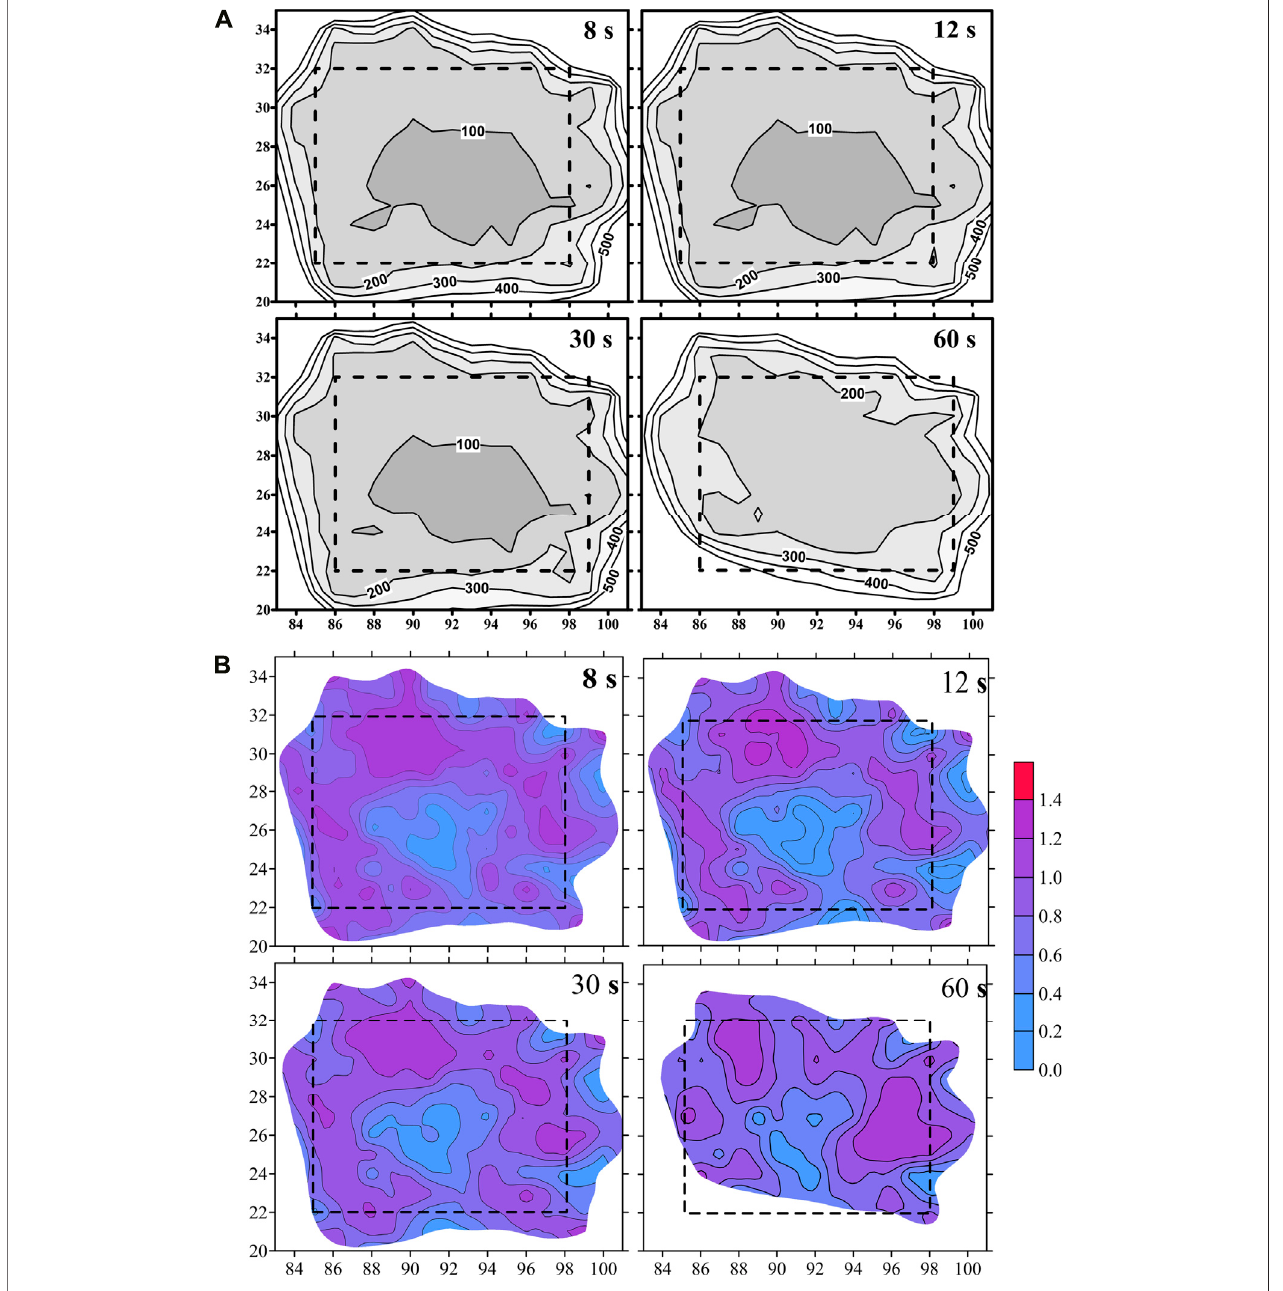
FIGURE 3 | Contoured diagrams of (A) mean size of averaging resolution length (in km) and (B) distribution of stretching parameter. Areas, where the resolution length of tomographic image > 200 km, are clipped and shaded white. An area having a good resolution is demarcated by a rectangular box marked with dashed lines.